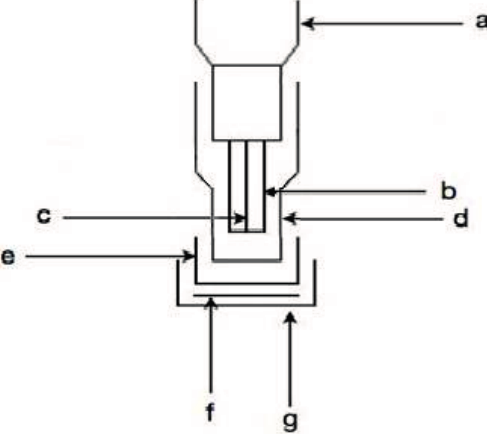
Figure 1. Assembly diagram of the SOD biosensor. a : electrode body; b : Ag/AgCl/Cl − cathode; c : platinum anode (+ 650 mV); d : plastic cap; e : cellulose acetate membrane; f : Kappa-carrageenan disk containing SOD enzyme; g : dialysis